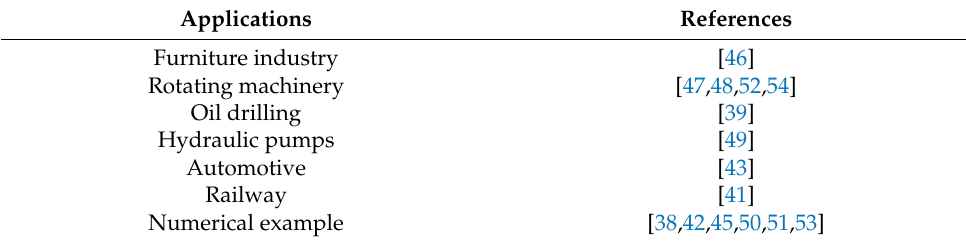
Table 8. Evaluation of joint scheduling and